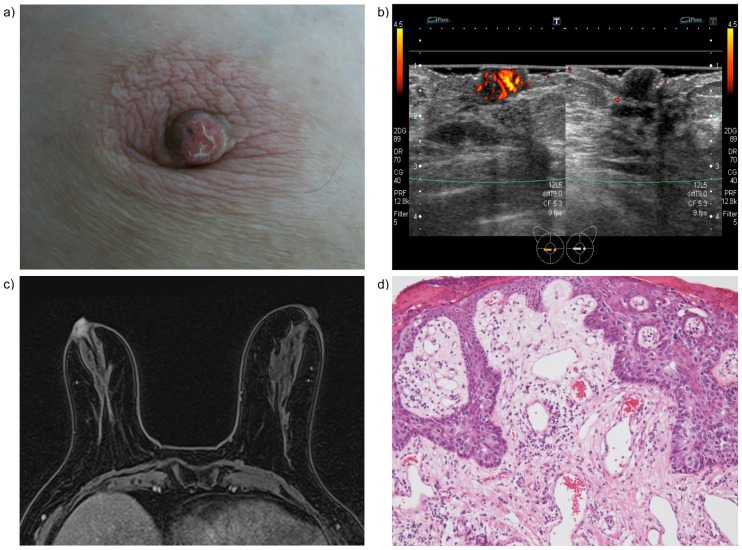
An 81-year-old woman with Paget disease (Case 7).(a) Scaling and erosion of the affected right nipple. (b) Blood flow signals inside the affected nipple as observed using Doppler sonography. (c) Nipple enhancement by CE-MRI. (d) Histopathological examinations with hematoxylin and eosin staining reveal Paget cells within the epidermis and capillary proliferation within the dermis (×100).